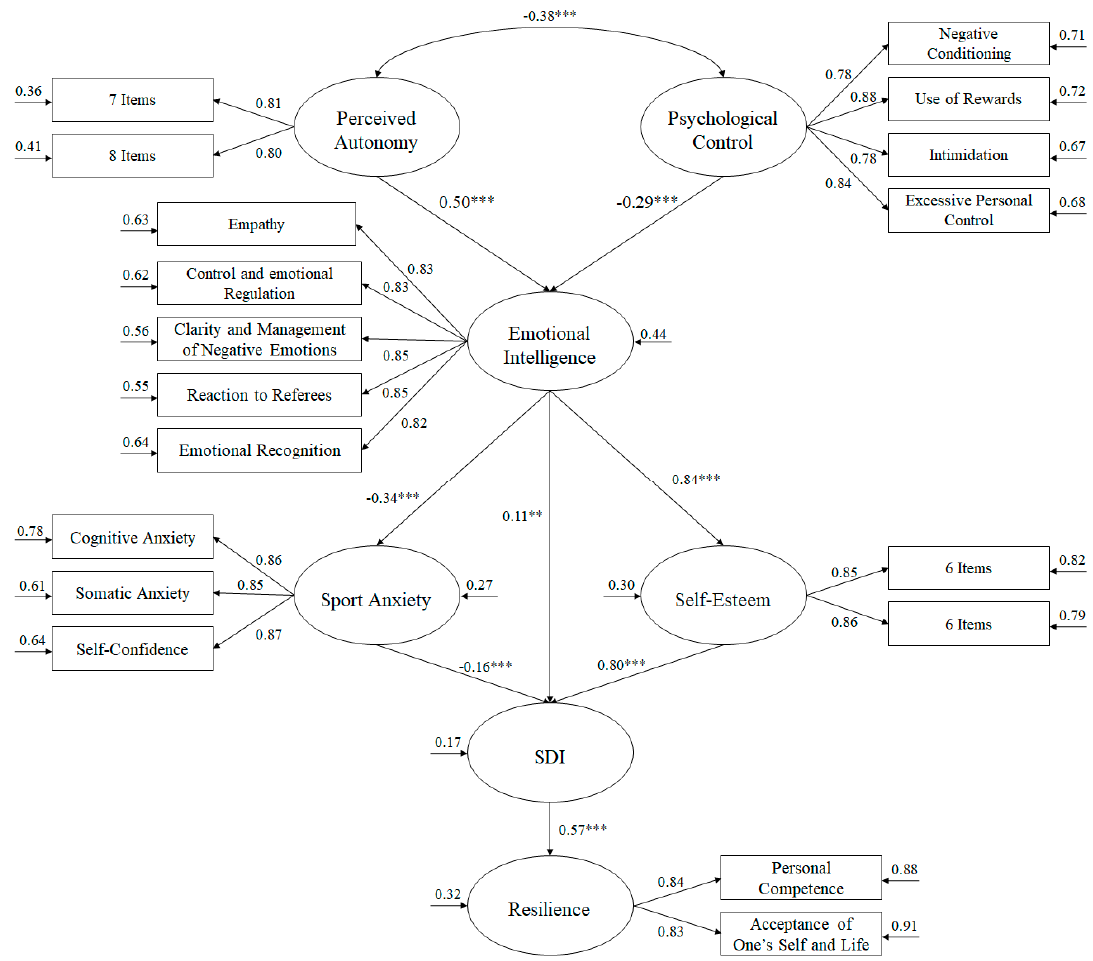
Figure 1. Model of structural equations showing the relationships between the different variables. All parameters are standardized and statistically significant. The variances explained are shown above the small arrows. Note: *** p < 0.001; ** p < 0.01; * p < 0.05. SDI = Self-determination index.